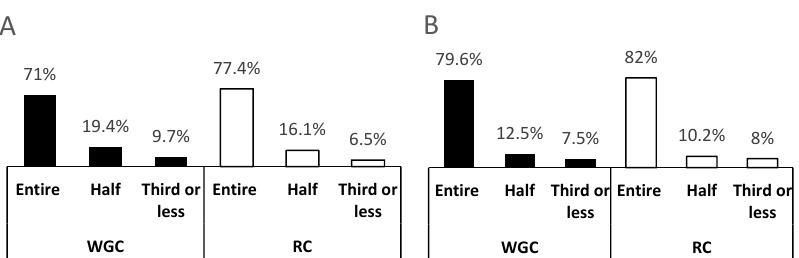
Figure 1. Infants’ consumption of the serving of infant cereals prepared by parents. WGC: Whole Grain Cereal; RC: Refined Cereal. Values are expressed as percentage of total infants. ( A ) represents the consumption of cereals by infants 4–11 months of age; ( B ) consumption of cereals by infants 12–24 months of age.